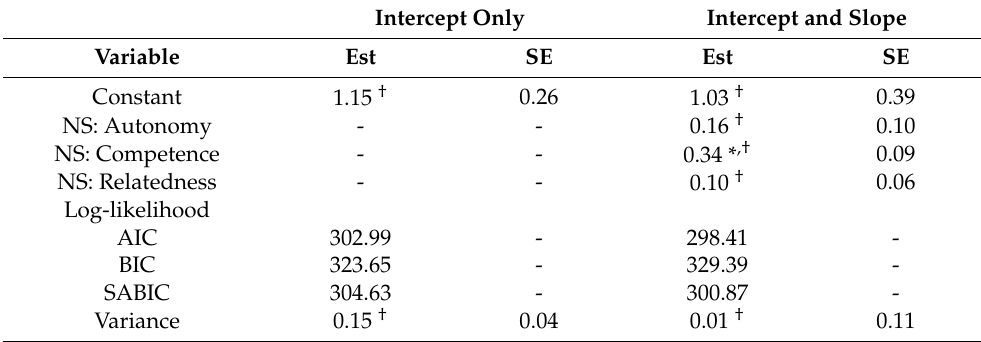
Table 3. The results from the multi-level modelling. Intercept Only Intercept and Slope Variable Est SE Constant